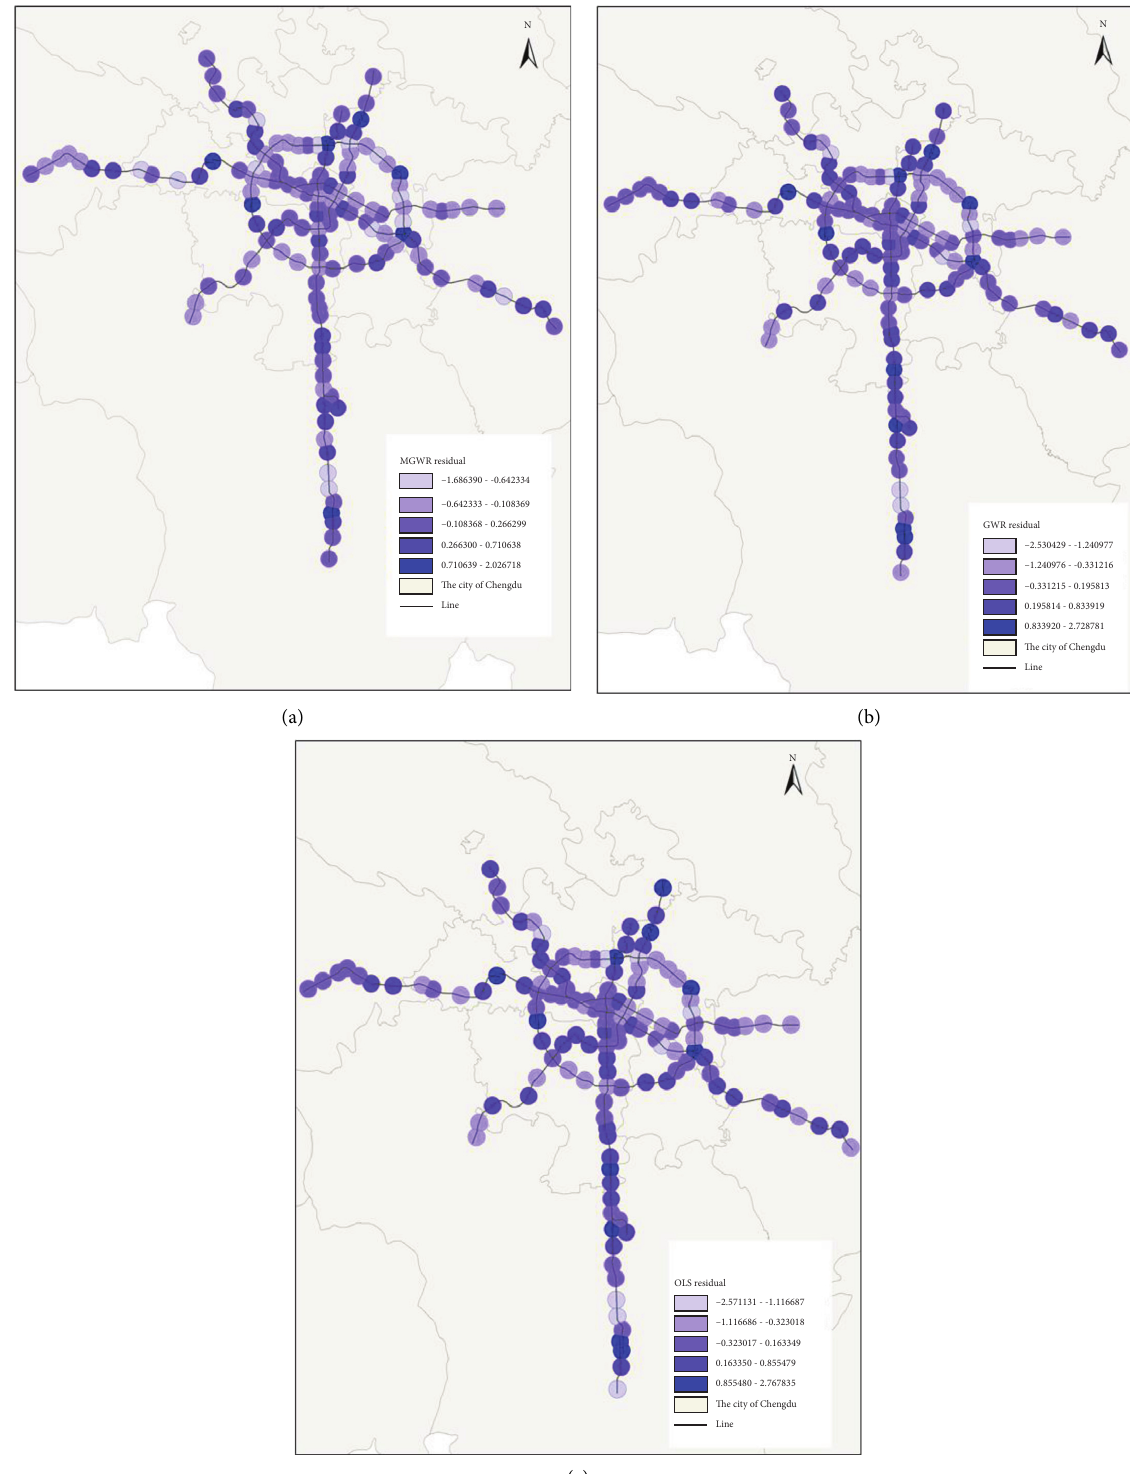
Figure 11: (a–c) Spatial distribution of the residuals of the MGWR, GWR, and OLS